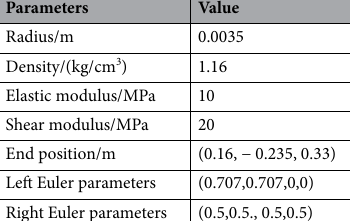
Table.1. Physical parameters and boundary conditions of cable.